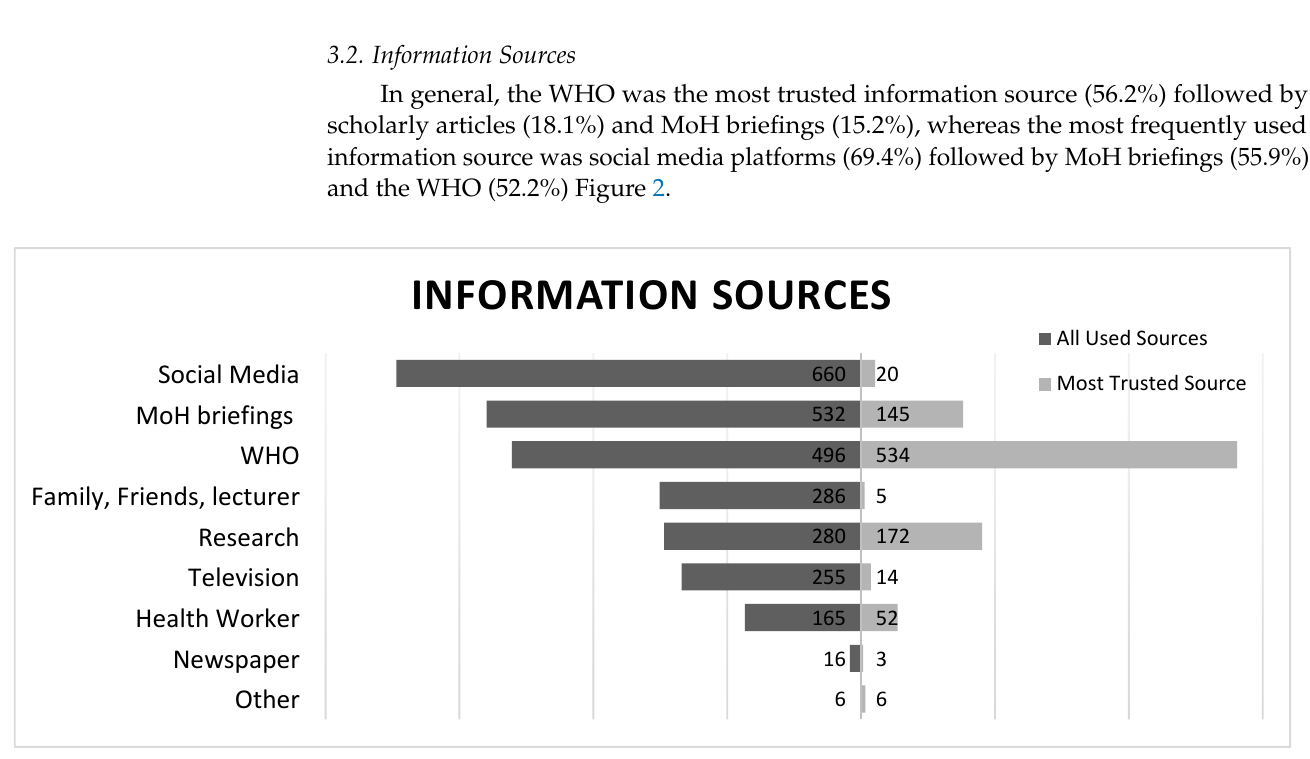
Figure 1. Response rate and representativeness of the participating students: ( a ) response rate; and ( b ) representativeness by gender and ( c ) by study program.